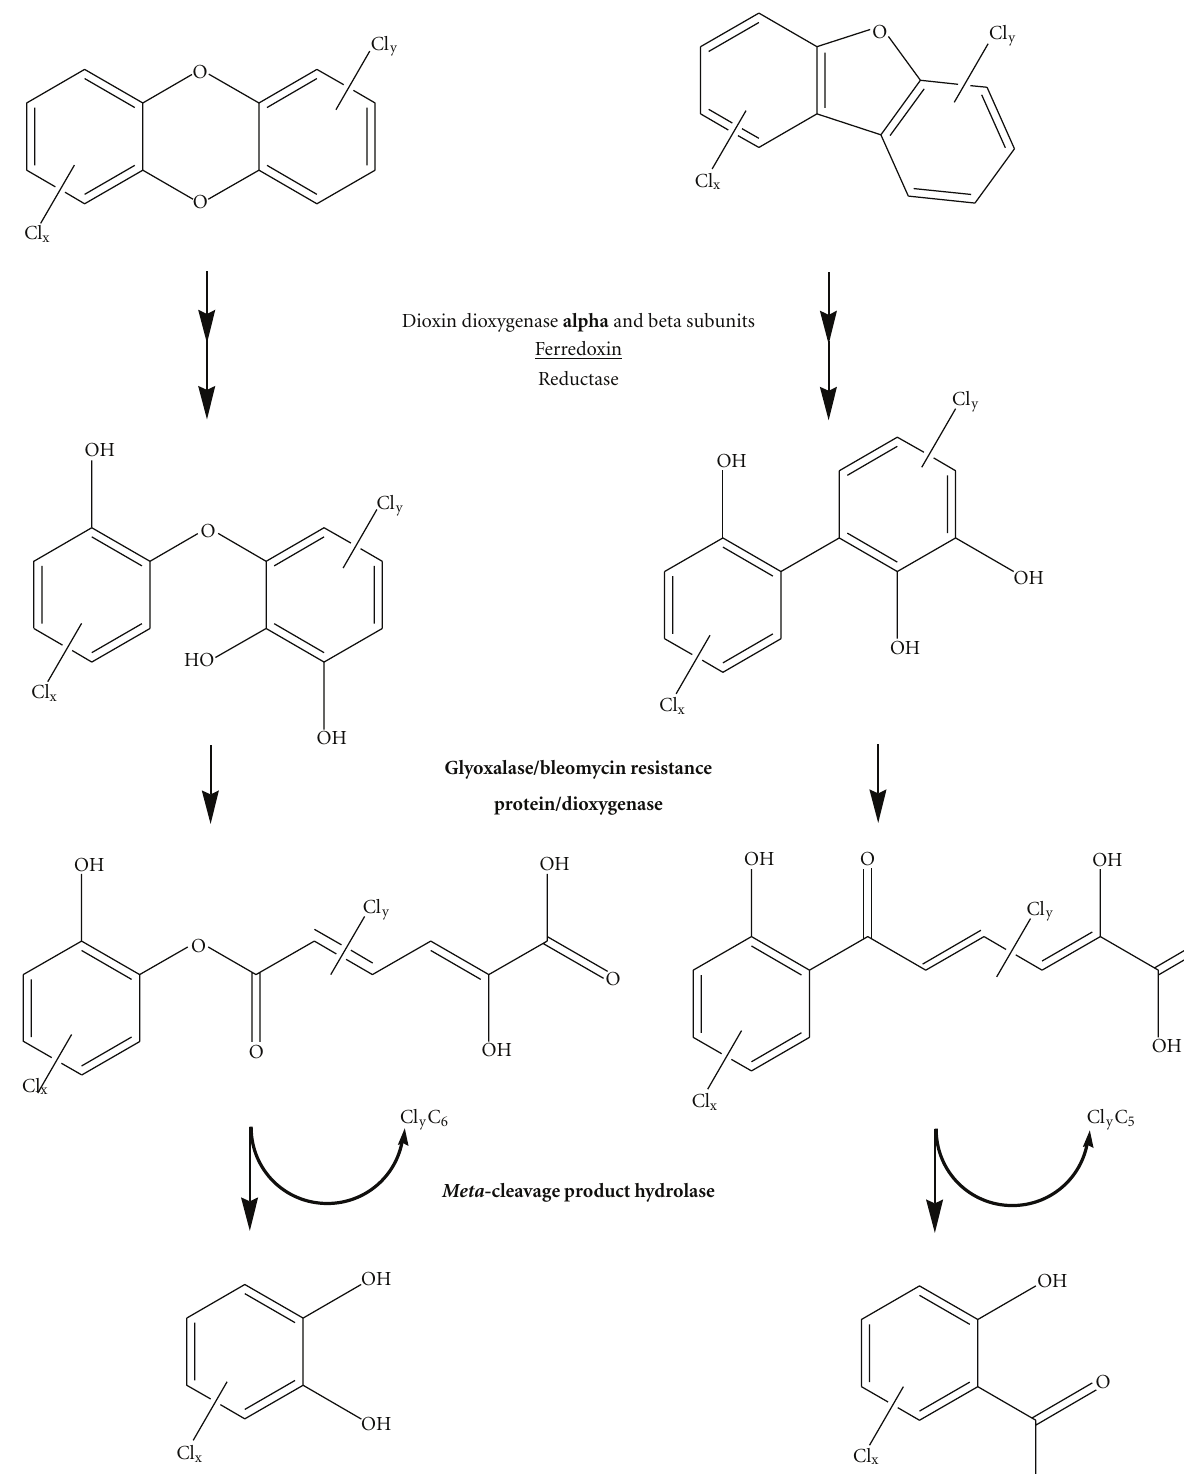
Figure 4: The dioxin (left) and dibenzofuran (right) degradation pathways. Enzymes catalyzing individual reactions are written in the center. Bold typeface indicates a protein that was found to be increased in expression. The ferredoxin (underlined) is located in an operon whose expression was found to be decreased. Cl y C 5 and Cl y C 6 represent potentially chlorinated aliphatic